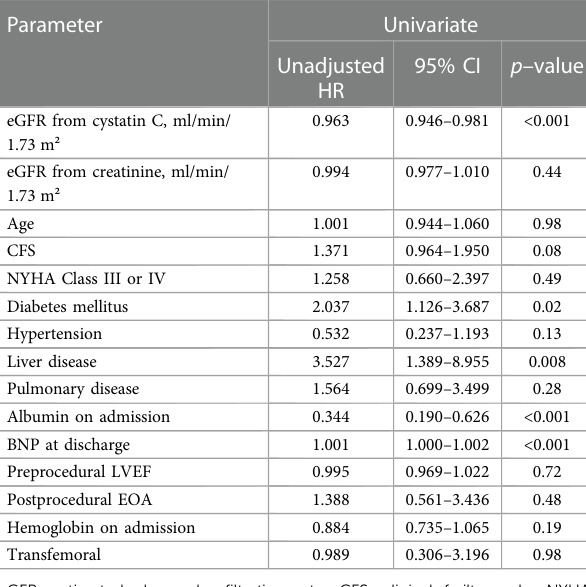
TABLE 3 Cox regression univariate analysis for the association between cumulative mortality and clinical fi ndings.